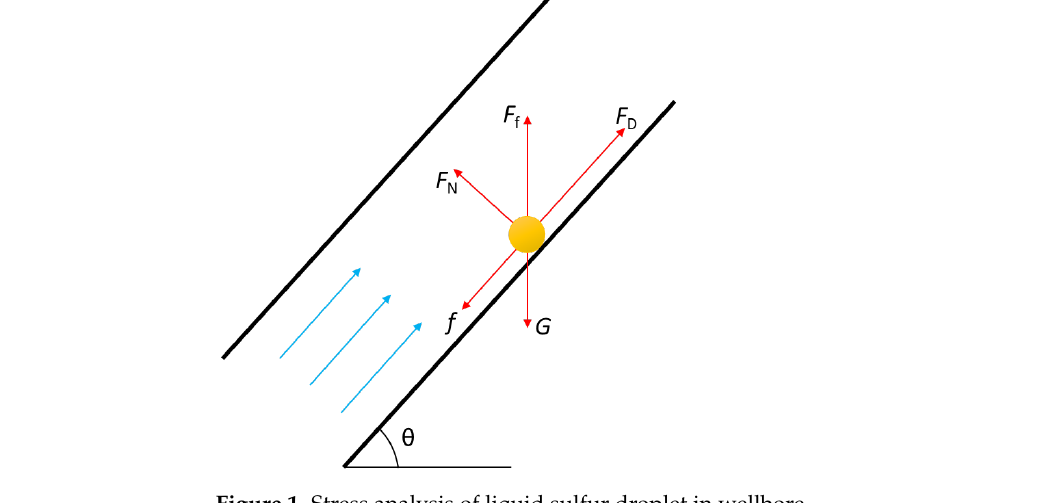
Figure 1. Stress analysis of liquid sulfur droplet in wellbore.